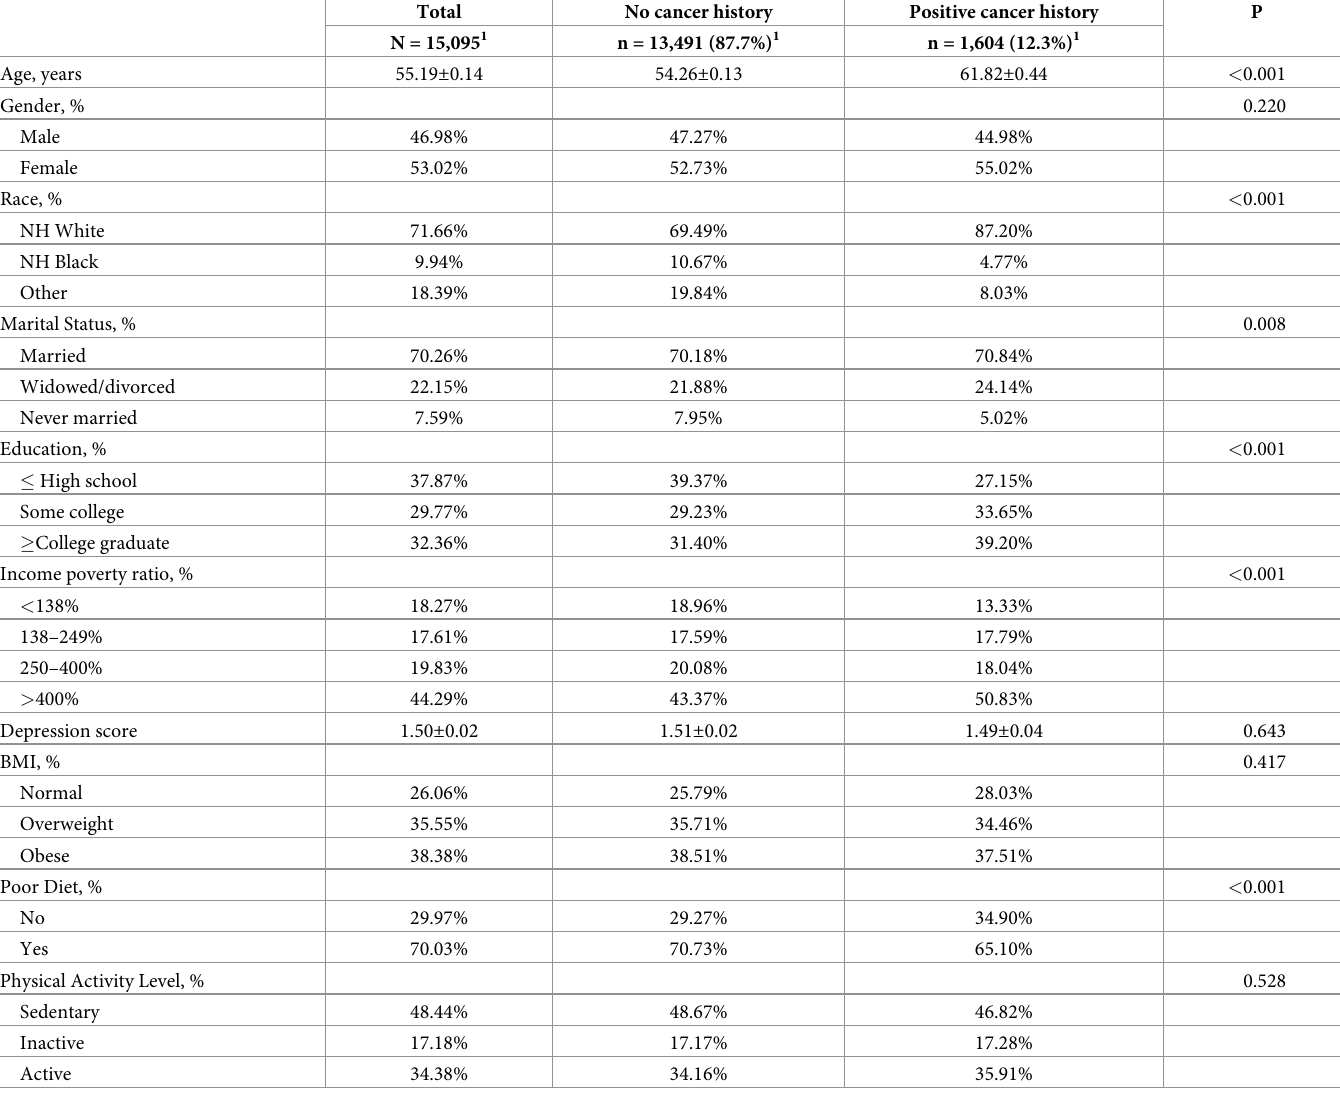
Table 1. Baseline characteristics of 1,604 individuals with a cancer history and 13,491 individuals without a cancer history, 2007–2016